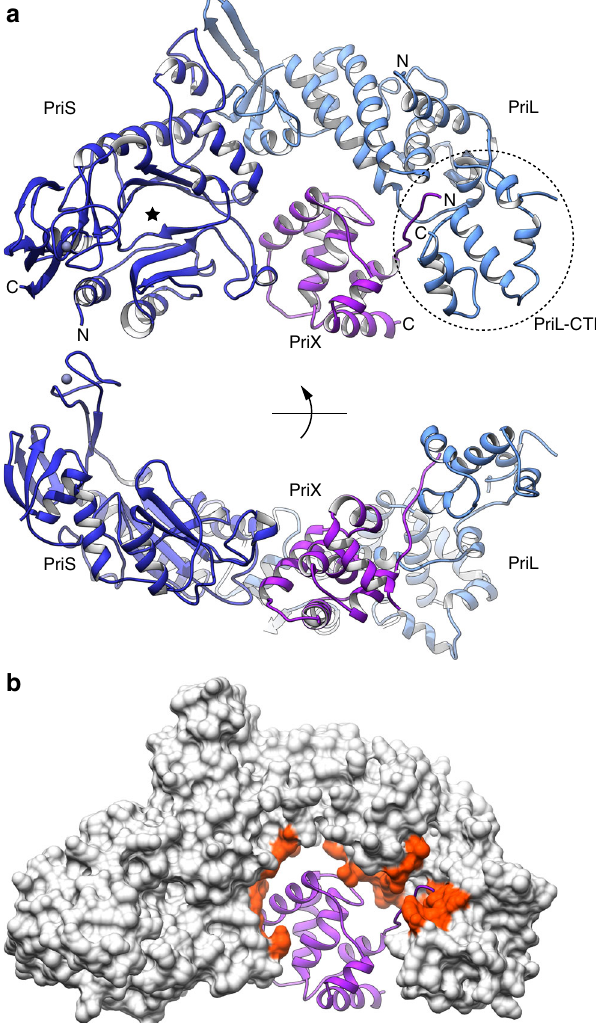
Fig. 1 Crystal structure of the heterotrimeric primase PriSLX from S. solfataricus . a Two views of the PriSLX structure. The three subunits are drawn as ribbons, colored blue (PriS), light blue (PriL) and purple (PriX). The position and extent of the PriL-CTD is highlighted by a dashed